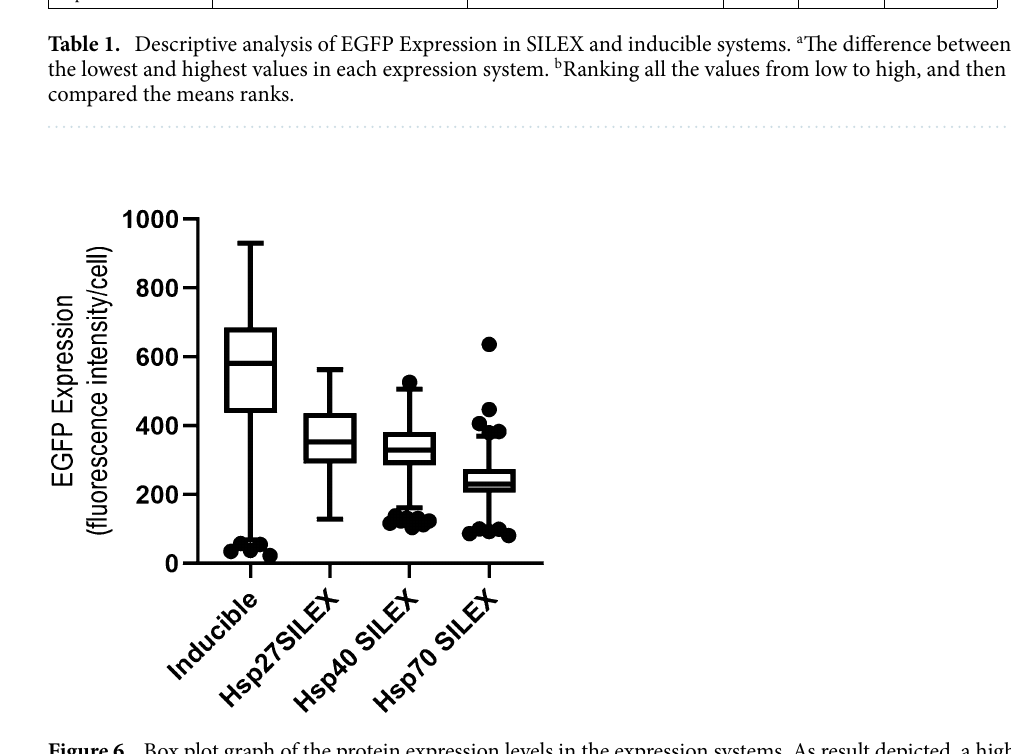
Figure 6. Box plot graph of the protein expression levels in the expression systems. As result depicted, a higher variation was observed for the IPTG-inducible system in contrast to the SILEX